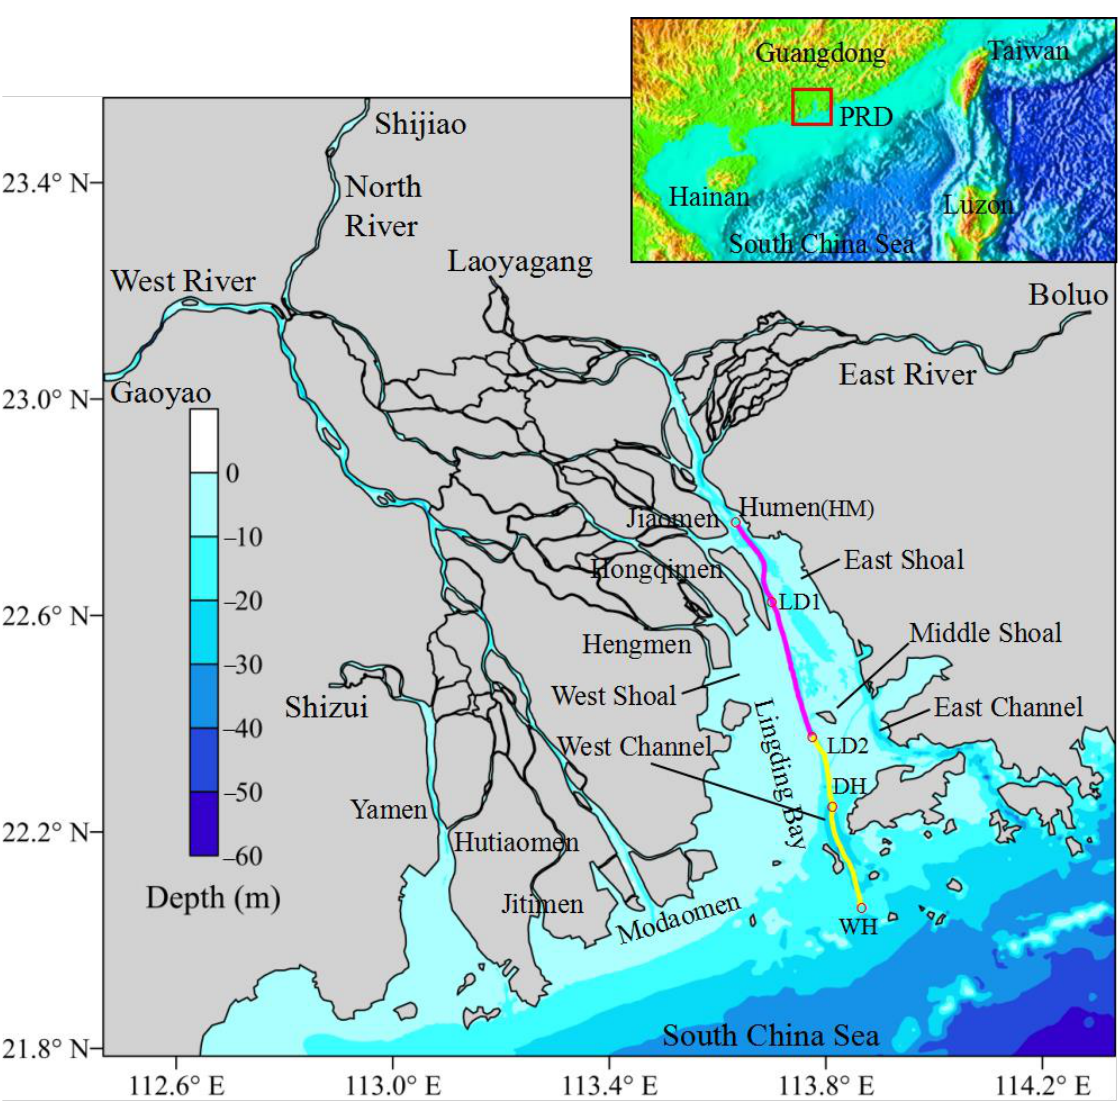
Figure 1. The location and topography of the Pearl River Delta (PRD). The line represents the transect along the West Channel with the purple part in the Inner Lingding Bay and the yellow part in the Outer Lingding Bay.